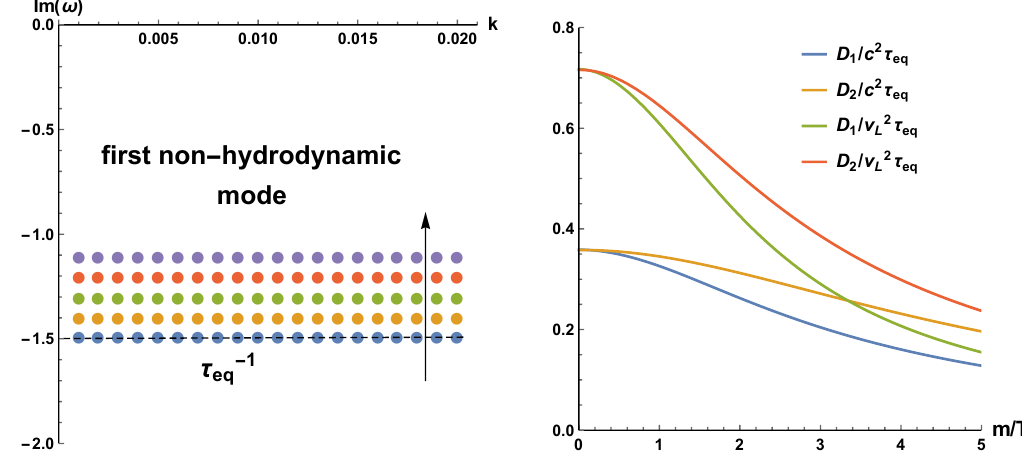
Figure 7: The upper bond on diffusion at zero charge. In this case D diffusion and D the charge diffusion. Left: We extracted the thermalization time 2 from the imaginary part of the first non-hydrodynamic mode as in Eq.(60). c is the speed of light and v is the speed of longitudinal sound. The arrow in the upper L panel indicates the motion increasing m / T . Right: The dimensionless ratios. All of them get values in the range [ 0,1 ] , implying that the upper bound is